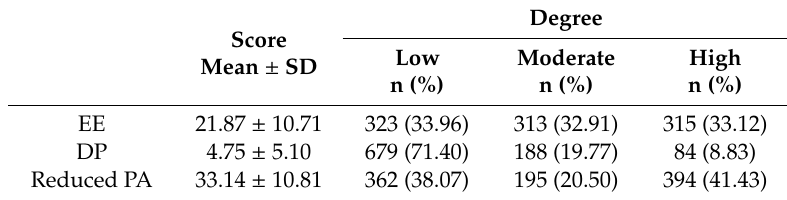
Table 2. Burnout symptoms in primary care providers (n =